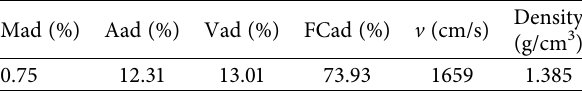
Figure 1: Triaxial stress thermal-hydro-mechanical coal containing gas permeameter Table 1: Main physic parameter of the sample [3].